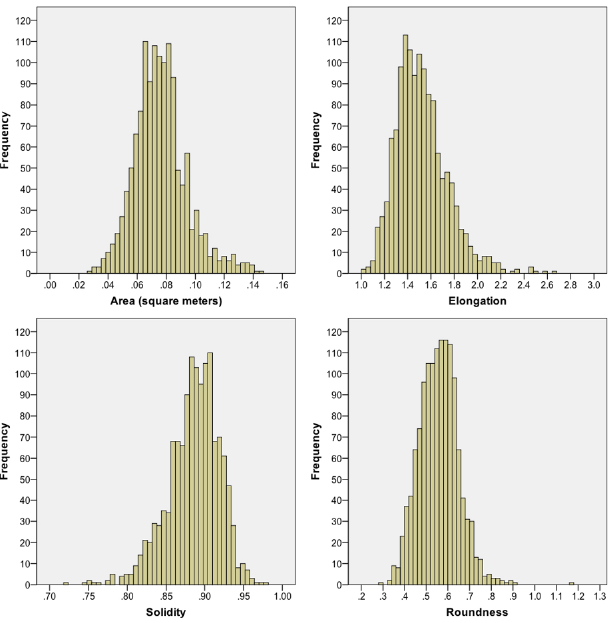
Fig. 5 . Frequency histograms showing the distribution of values for four spatial attributes among 1335 manually identified Lesser Snow Geese ( Chen caerulescens caerulescens ) in 4-cm resolution aerial